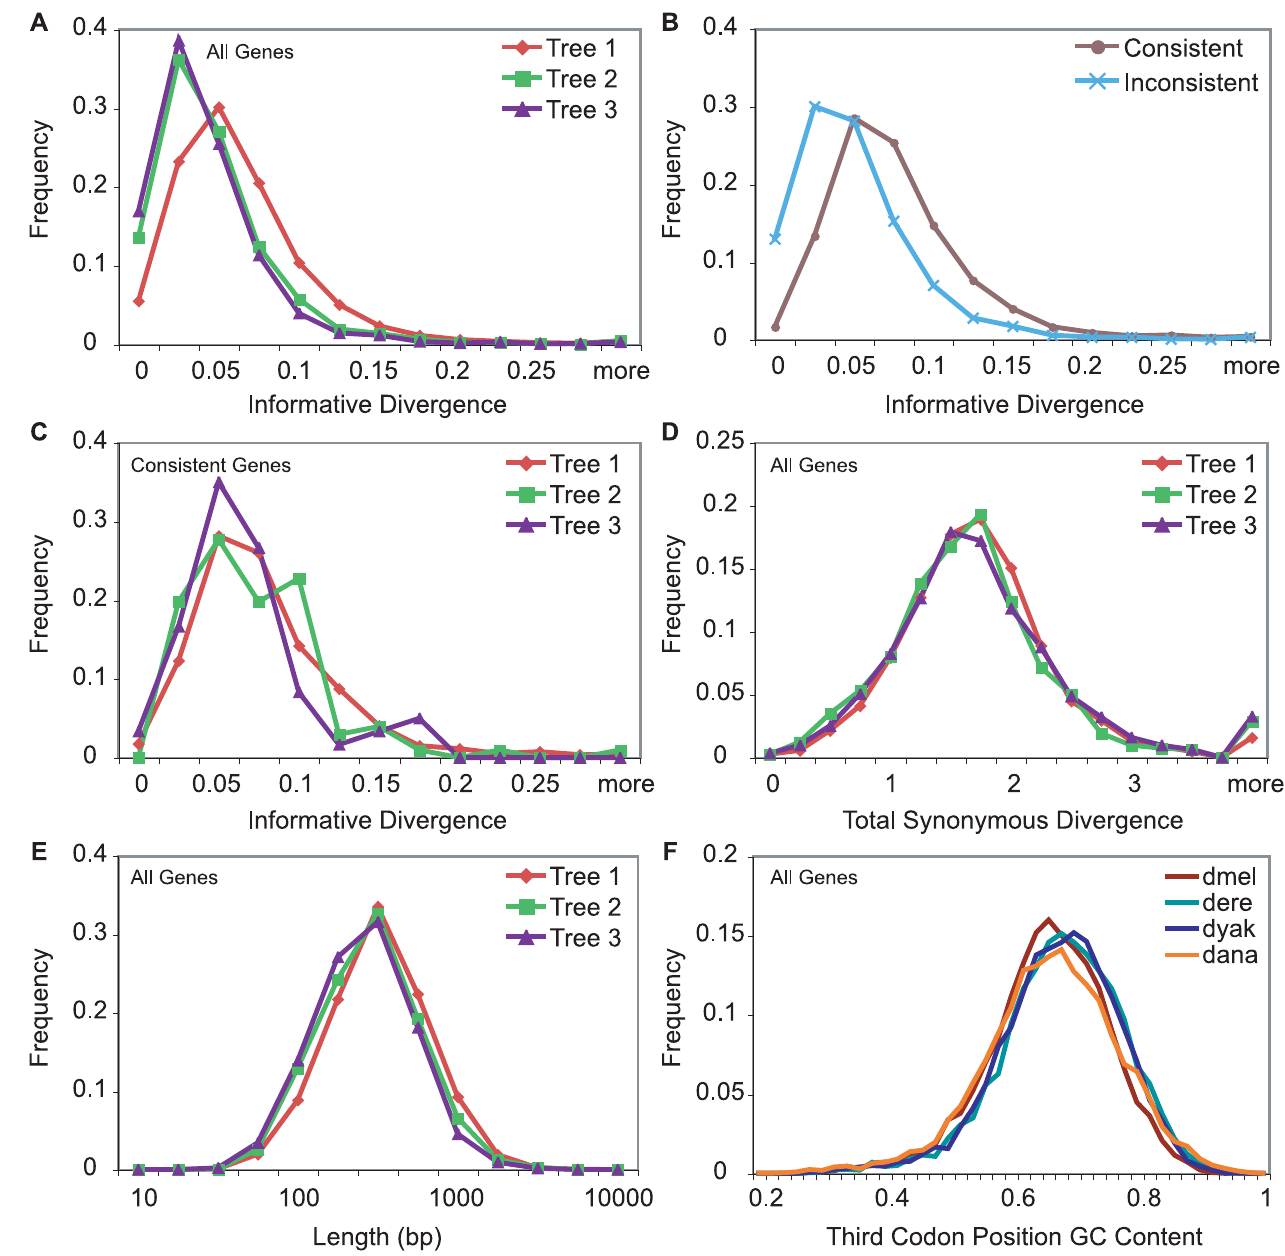
Figure 8. Sequence and Evolutionary Gene Properties Sequence and evolutionary properties of the genes are unable to explain the incongruence. Distributions are calculated using results from the original ML analysis using the F3 3 4 model and the Dmel, Dere, Dyak, and Dana species combination. The distributions of informative synonymous divergences in genes supporting each tree reveal a bias toward lower values for the incongruent genes (A). Nearly all genes with little or no informative synonymous divergence, however, are classified as inconsistent (B). Therefore, consistent genes have very similar distributions of ISD across trees (C). TSD is distributed similarly across trees, suggesting homoplasy due to increased mutation rates is not causing the incongruence (D). Gene length is slightly higher in tree 1 genes but overall is very similar across trees (E). Third codon position GC content is slightly biased toward lower values for Dmel and Dana and higher values for Dere and Dyak, creating a conservative bias for the incongruence (F). DOI: 10.1371/journal.pgen.0020173.g008